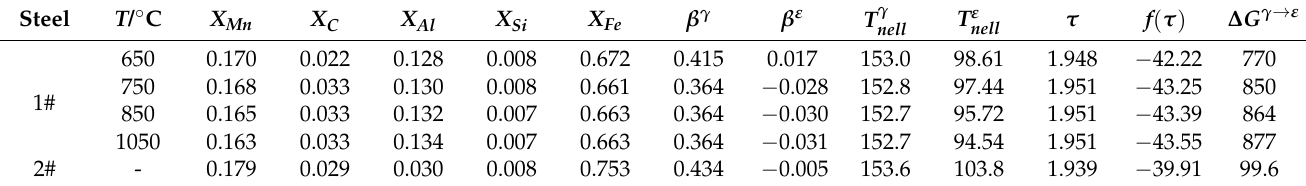
Table 4. Parameters related to temperature adopted for the SFE (stacking fault energy) calculation of experimental steels. X i” the mole fraction of component i . τ = T / T nell